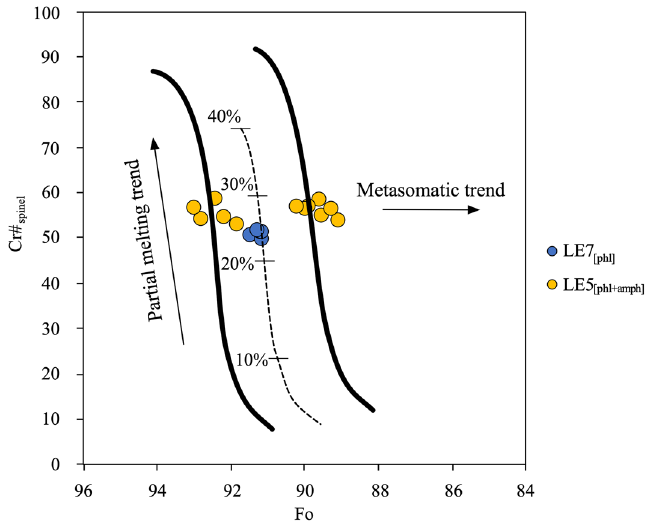
Figure 2. Plot of Cr# Sp [Cr/(Cr + Al) mol × 100] versus Fo [Mg/(Mg + Fe) mol × 100] contents in olivine, for Mount Leura (LE) peridotite xenoliths. The olivine-spinel mantle array (OSMA) and melting trend are from Arai 47 . The “metasomatic trend” is generally referred to as the effect of interaction with a migrating